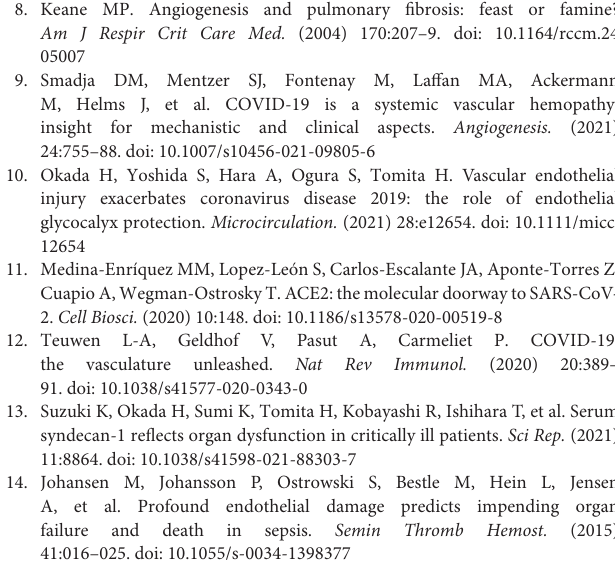
Supplementary Figure 1 | Strobe diagram. Supplementary Table 1 | Healthy volunteers’